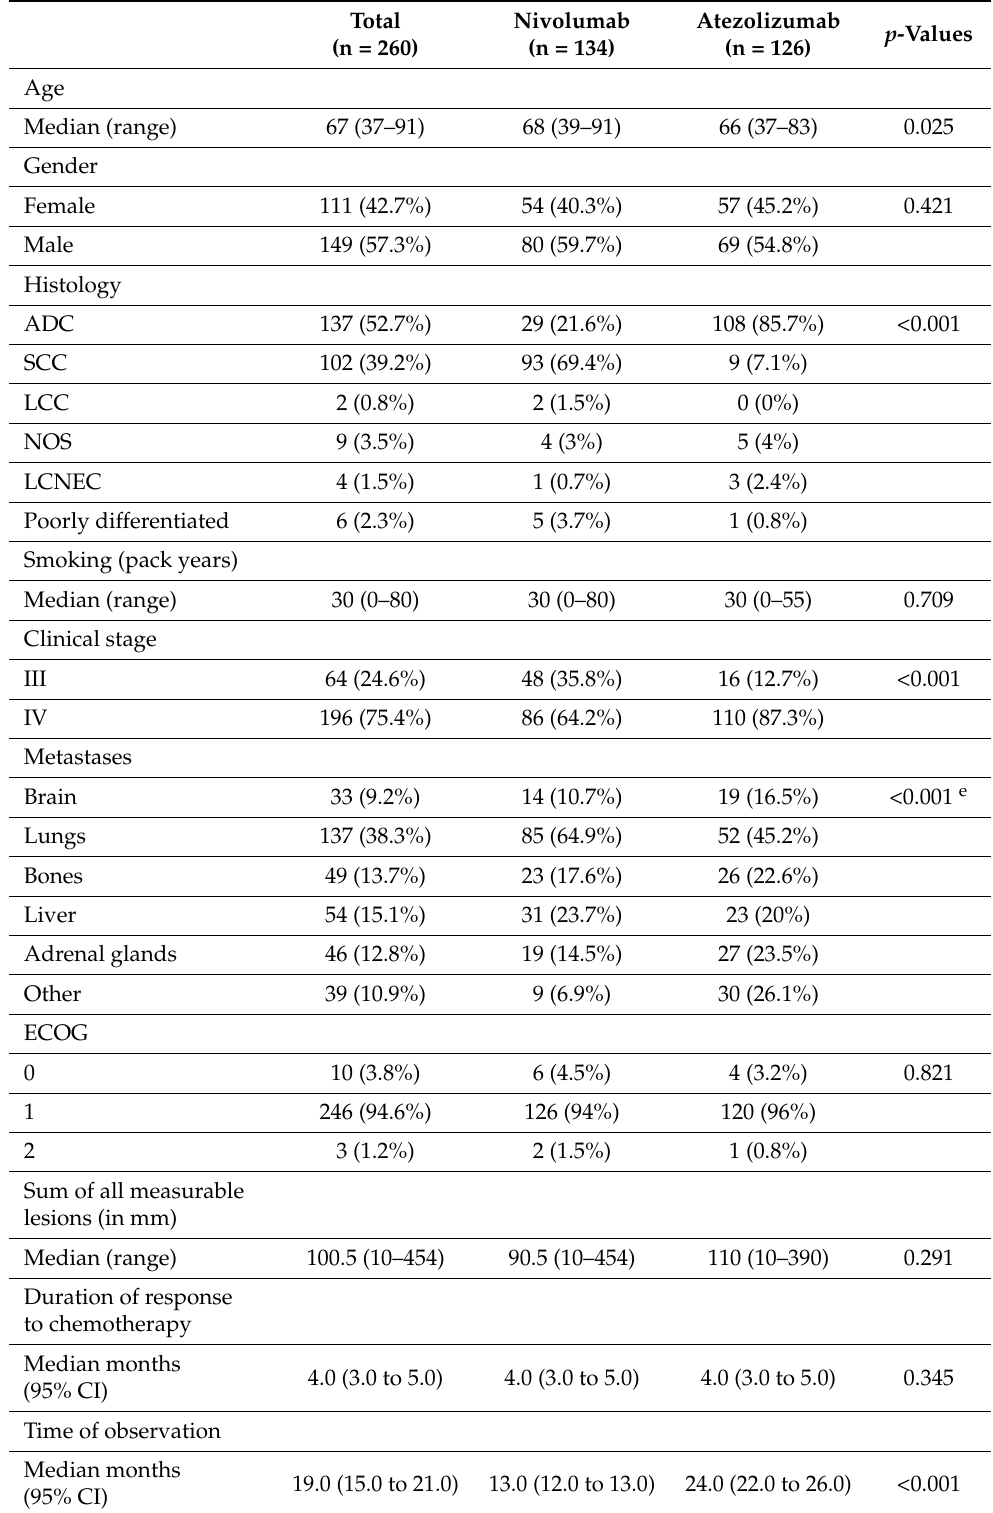
Table 1. Baseline demographic and clinical characteristics by type of the